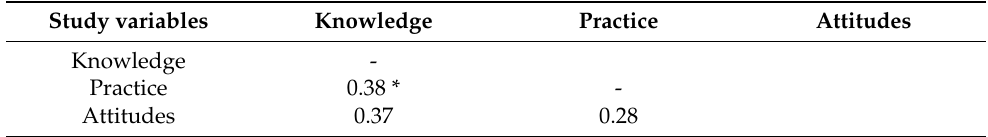
Table 8. Correlations (Spearman’s rho) between the total scores of knowledge level, practice and